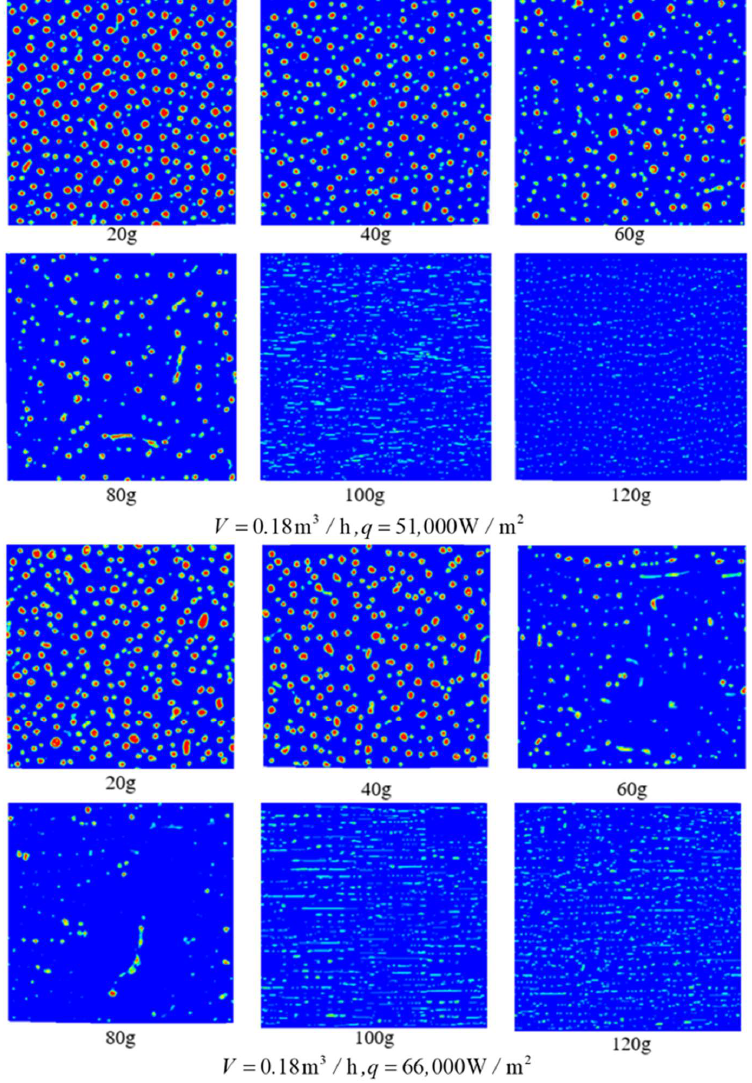
Figure 15. Bubble distributions inside the liquid